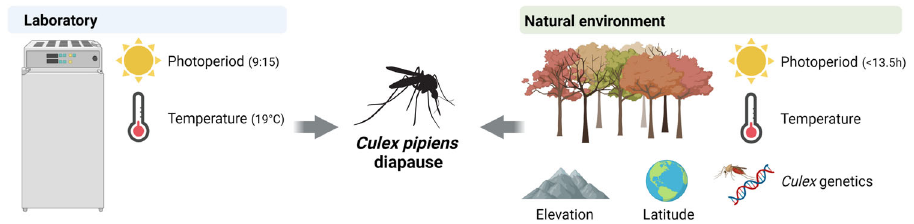
Fig. 5 Overview of the factors that in fl uence Cx. pipiens diapause in the laboratory and under natural conditions. The combination of short-day lengths and low temperatures form the basis for diapause induction in laboratory studies of Cx. pipiens , yet additional ecological factors (latitude,